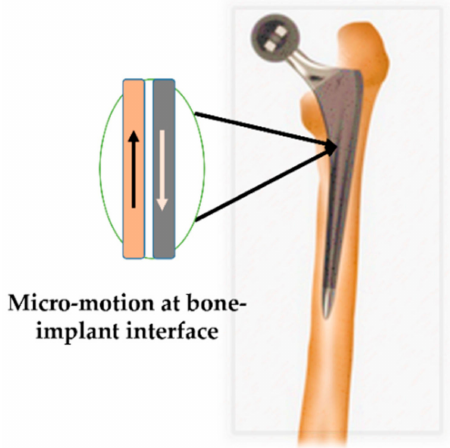
Figure 7. A typical bone–implant system with the micromotion region of interest is